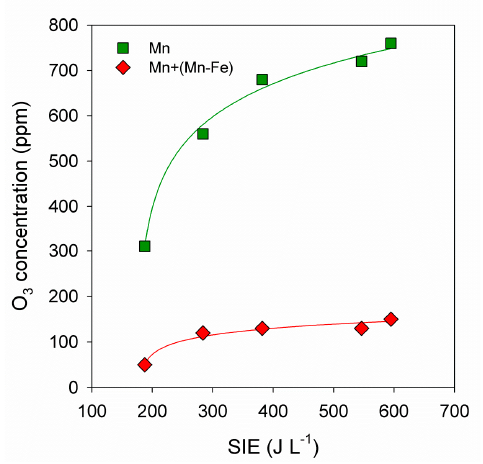
Figure 7. DEE decomposition efficiency of hybrid Mn+(Mn-Fe) reactor, one-stage reactor with Mn/cordierite, and two-stage reactor with Mn-Fe/cordierite.